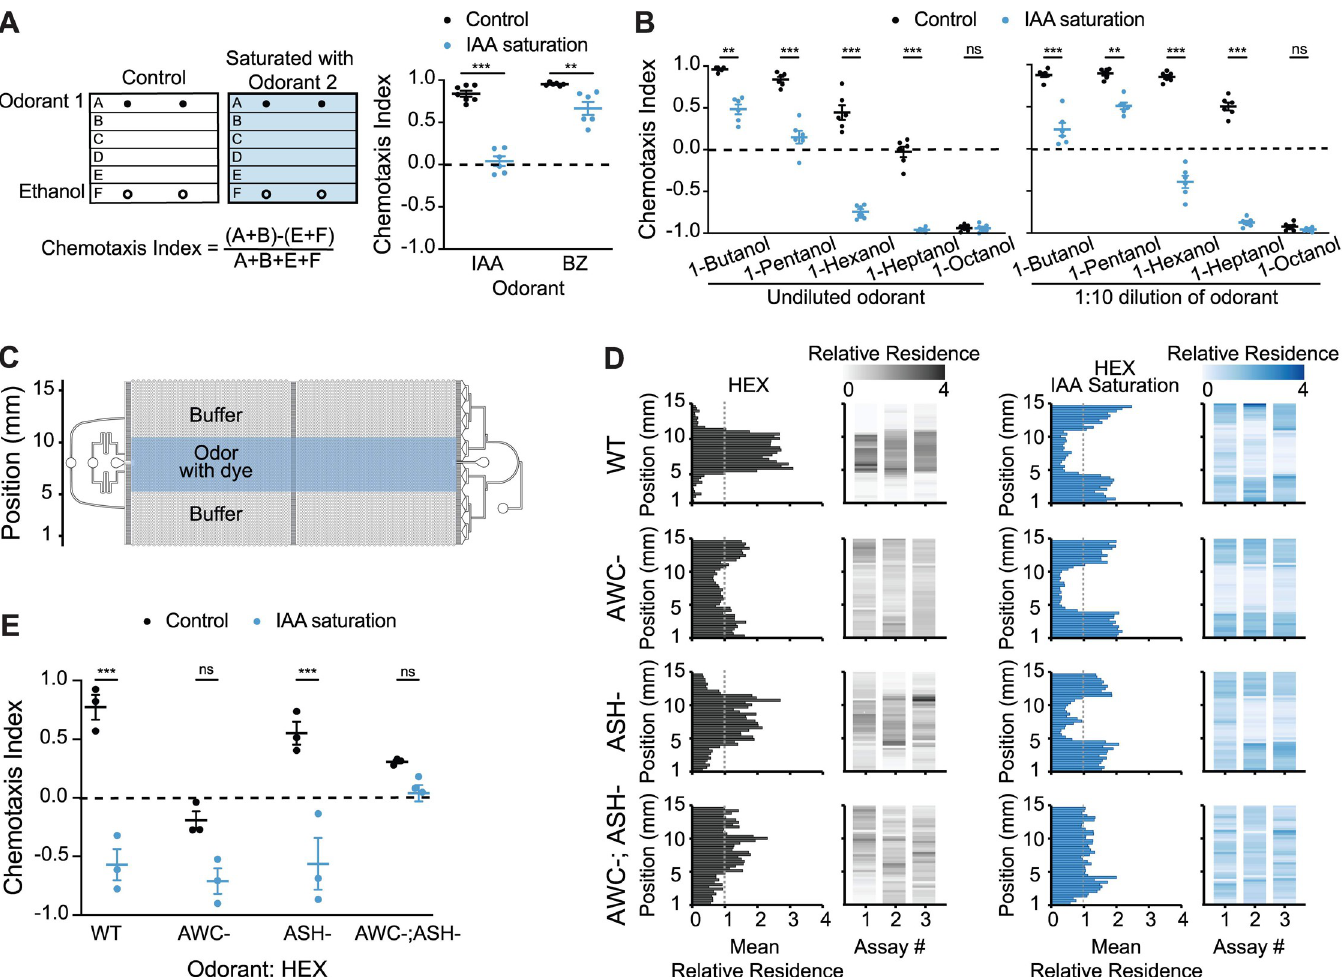
Fig 1. The AU : AbbreviationlisthavebeencompiledforthoseusedinFigs 1 (cid:0) 4 andS 1 (cid:0) S 5 : Pleaseverifythatallentriesarecorrect : AWC neurons drive attraction or avoidance of hexanol in the absence or presence of sIAA, respectively. (A) (Left) Cartoon of plate chemotaxis assay (see Materials and methods). Filled and open circles: location of 1 μ l each of the test odorant or ethanol. Positive and negative chemotaxis indices indicate attraction and avoidance, respectively. (Right) Behaviors of wild-type animals on control or sIAA plates. Test odorants: 1:200 dilution of BZ, 1:1,000 dilution of IAA. (B) Behaviors of wild-type animals on control and sIAA plates containing the indicated dilutions of different alcohols as the test odorants. (C) Schematic of the microfluidics behavioral device used in behavioral assays. Adapted from [42]. (D) Average histograms showing mean relative x-y residence (relative to spatial odor pattern) of animals of the indicated genotypes over 20 minutes in devices with a central stripe of 10 − 4 HEX without (left), or with, a uniform concentration of 10 − 4 IAA (right) in the device. Indicated neurons in each examined strain were genetically ablated via the expression of caspases (S1 Table). Mean relative residence > 1 or < 1 (dashed vertical line) indicate attraction and avoidance, respectively. Corresponding heat maps show the density of tracks in the y -position for each assay. n = 20–30 animals per assay; 3 biological replicates. (E) Chemotaxis indices calculated from behavioral assays shown in D. In A, B, each dot is the chemotaxis index of a single assay plate containing approximately 100–200 adult hermaphrodites. Assays were performed in duplicate over at least 3 days. In E, each dot is the chemotaxis index from a single assay in behavior chips. Long horizontal bars indicate the mean; errors are SEM. �� , ��� : P < 0.01 and 0.001, respectively (A, B: Kruskal–Wallis with post hoc pairwise Wilcoxon test and Benjamini–Hochberg method for P -value correction; E: 2-way ANOVA with Bonferroni’s correction); ns, not significant. Underlying data are provided